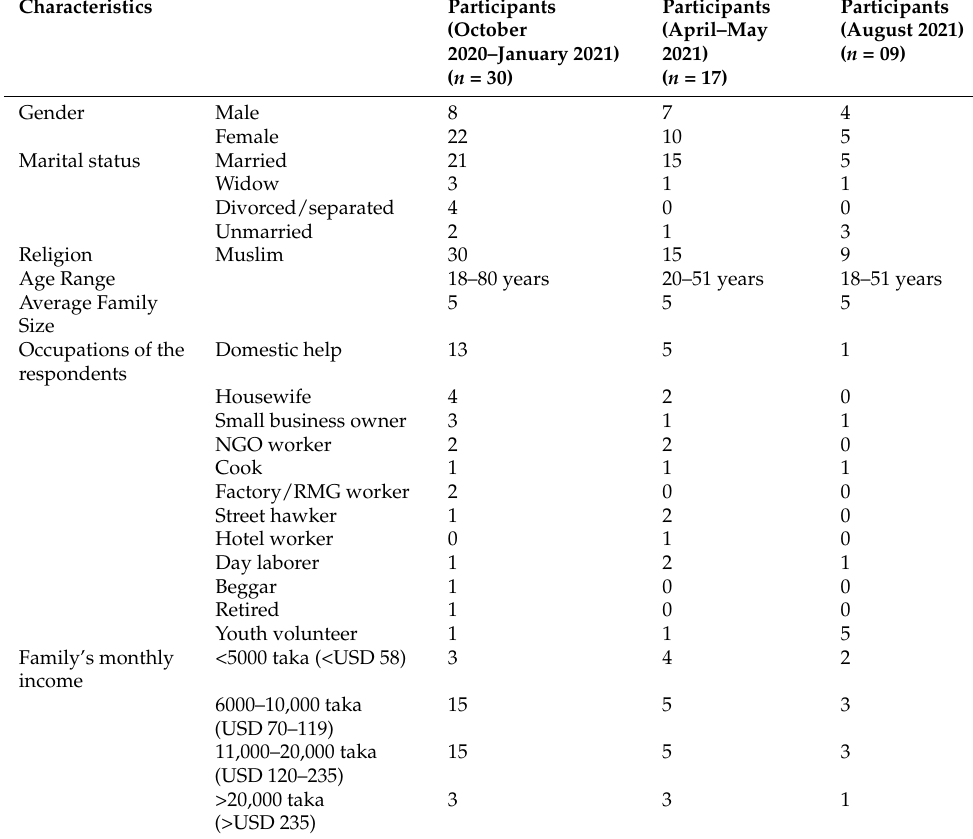
Table 3. Characteristics of the study participants across the different phases of the research.